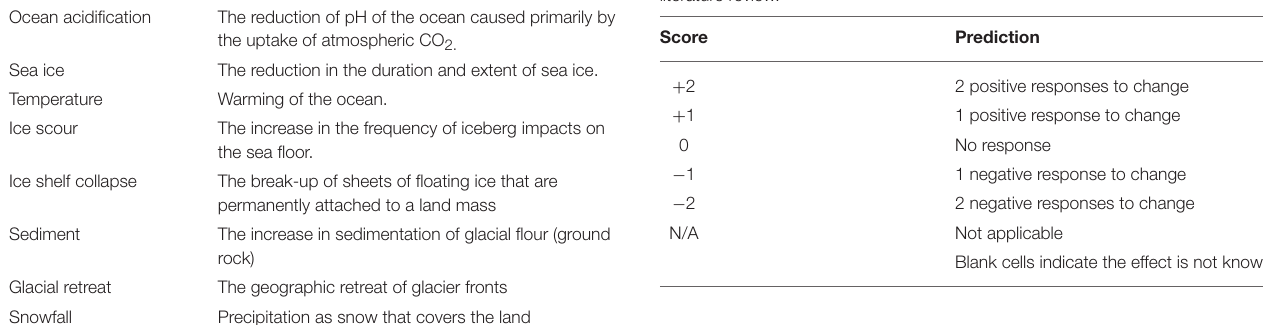
TABLE 2 | Scoring of expected species response to change based on the literature